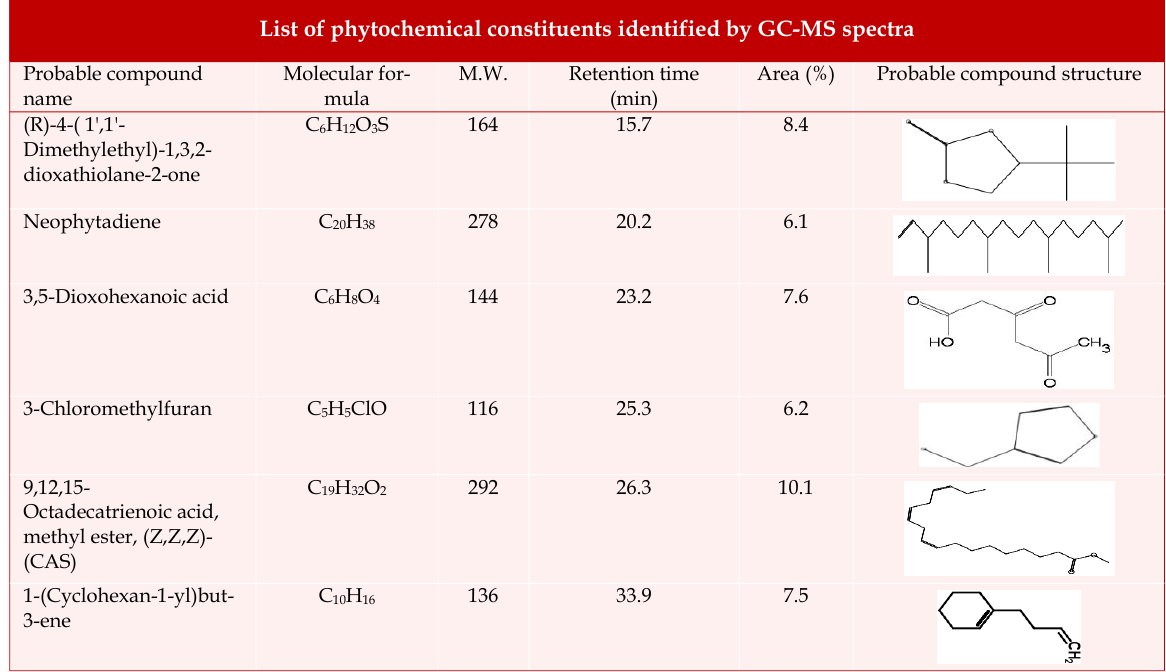
List of phytochemical constituents identified by GC-MS spectra